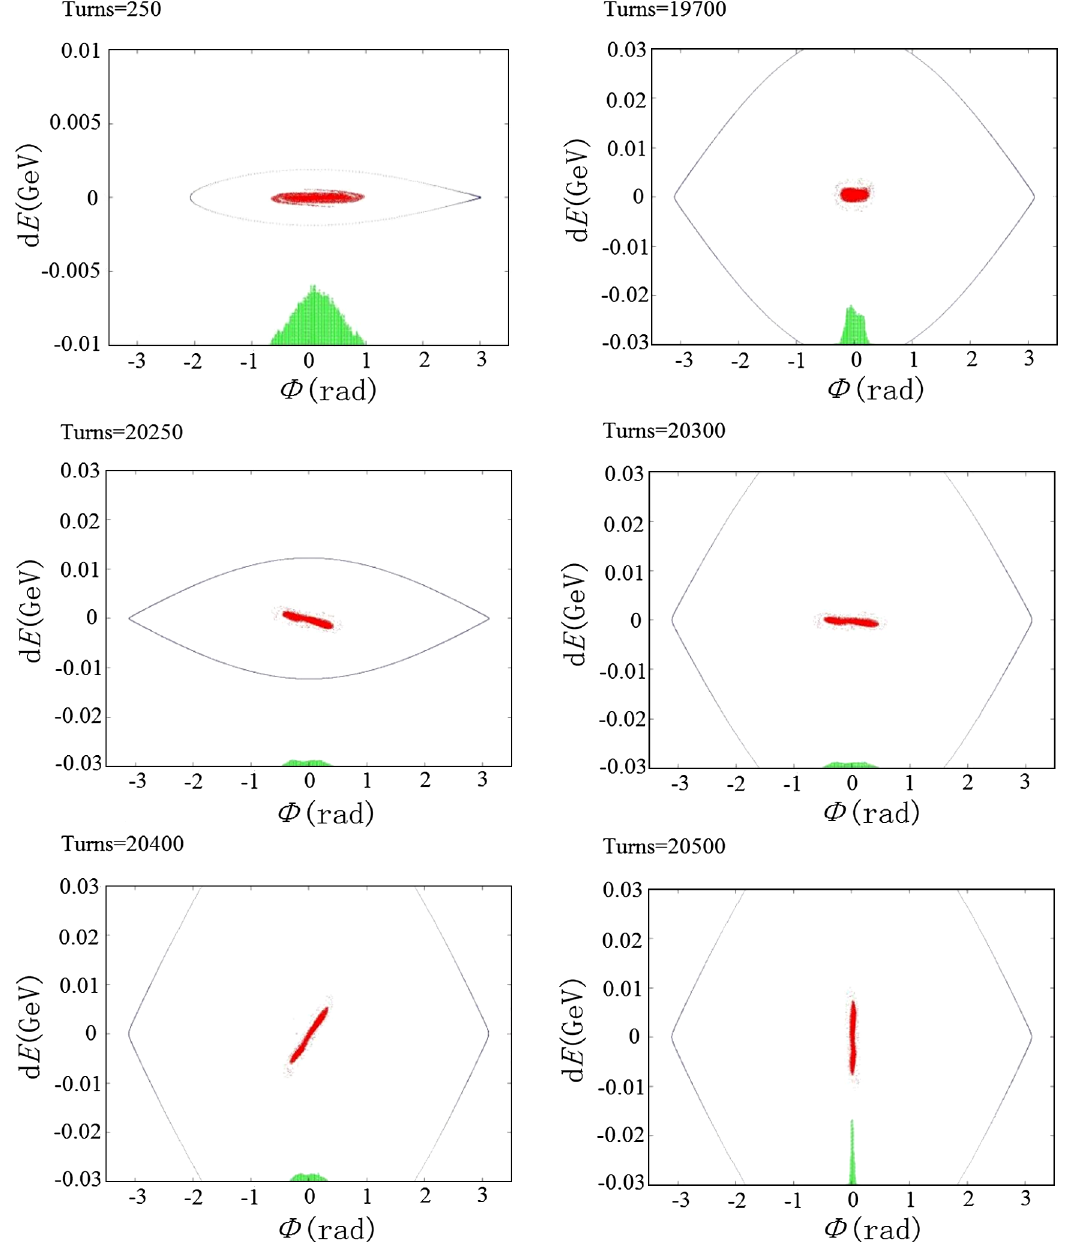
FIG. 4. Longitudinal beam distributions during the bunch compression process in the case of mode D. (Upper left to lower right, lines correspond to the moments of the end of the injection, beginning and end of the adiabatic process, beginning, middle, and end of the bunch rotation,